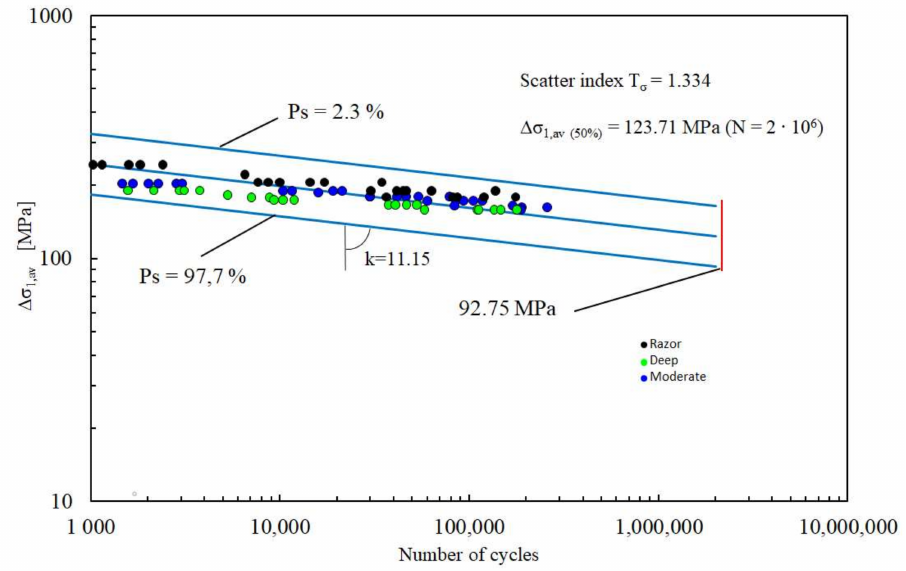
Figure 7. Synthesis of PEEK fatigue data by means of the line